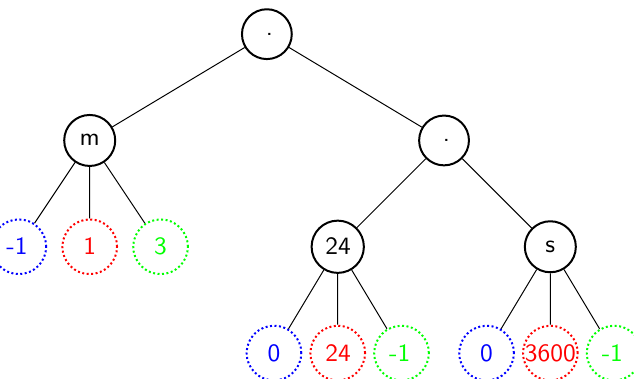
Figure 4. The figure shows the final unfolding of the binary tree. The dotted nodes are not actual children. Instead, they signify the metric prefix exponent (blue), value (red) and dimension (green) associated with the respective UCUM symbol. Note that the initial division operator and its subtree have been inverted by multiplying the dimension exponent with minus one.